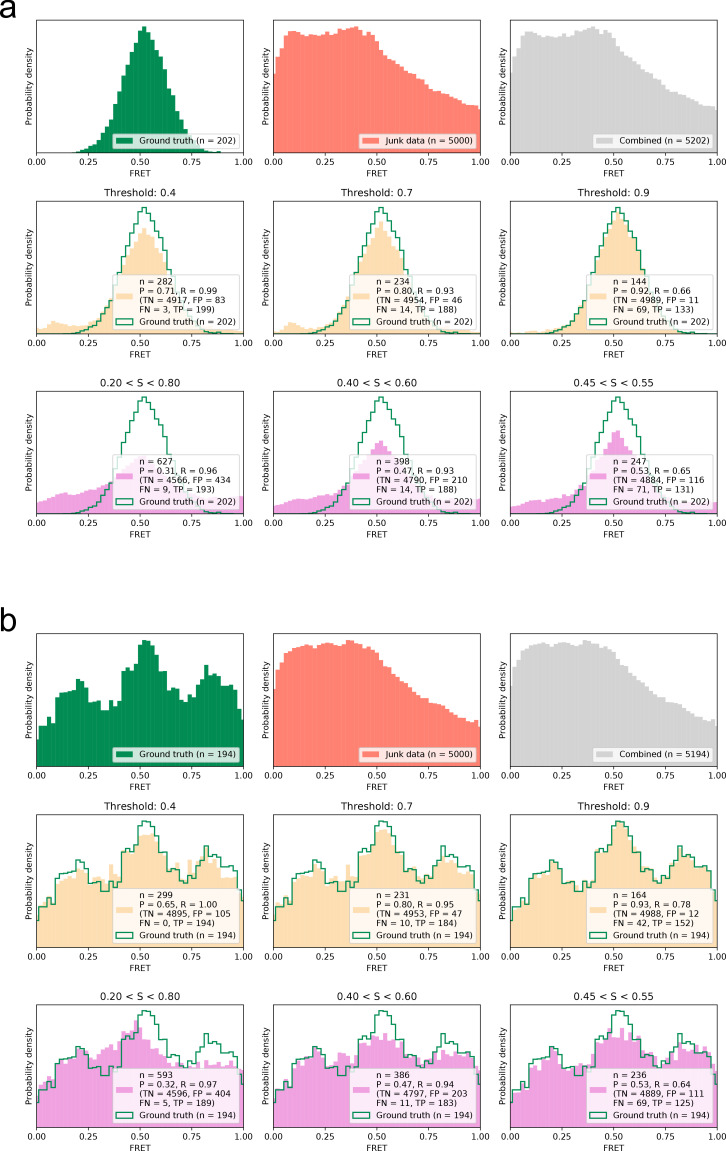
Comparison of smFRET distribution recovery by DeepFRET at different thresholds and semi-automated methodologies under various conditions in the absence of further human intervention.In each of the figures (a) and (b); Top: ground truth distribution and distribution of randomly selected non-smFRET data from an external test set. Middle: Performance of DeepFRET sorting at different thresholds. Bleached frames were excluded from analysis in all cases. Bottom: Performance of sorting by semi-automated methodologies using common thresholds-based sorting at different thresholds. Classification metrics for smFRET trace detection are shown in the graph. (a) The performance, given a 1-state system centered at FRET mean value 0.5. (b) The performance, given a 3-state system centered at FRET mean values 0.15, 0.5, and 0.85.